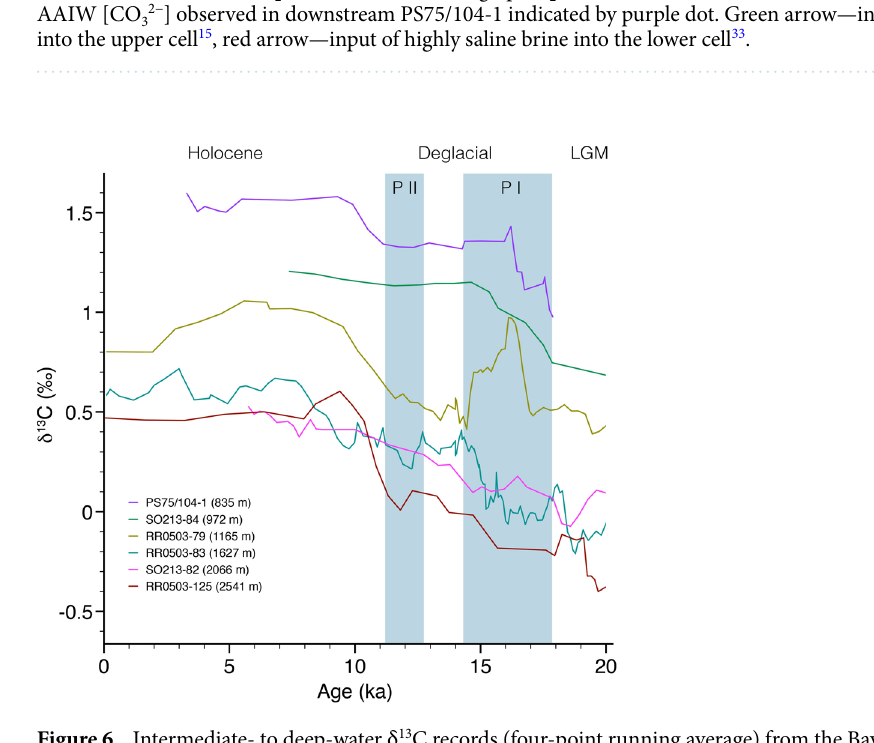
Figure 6. Intermediate- to deep-water δ 13 C records (four-point running average) from the Bay of Plenty (RR0503 cores) 17 and Chatham Rise 8 . The pattern and general trends of the shallowest core PS75/104-1 (this study) are very similar to Chatham Rise core SO213-84-1 15 and Bay of Plenty record RR0503-79 17 .